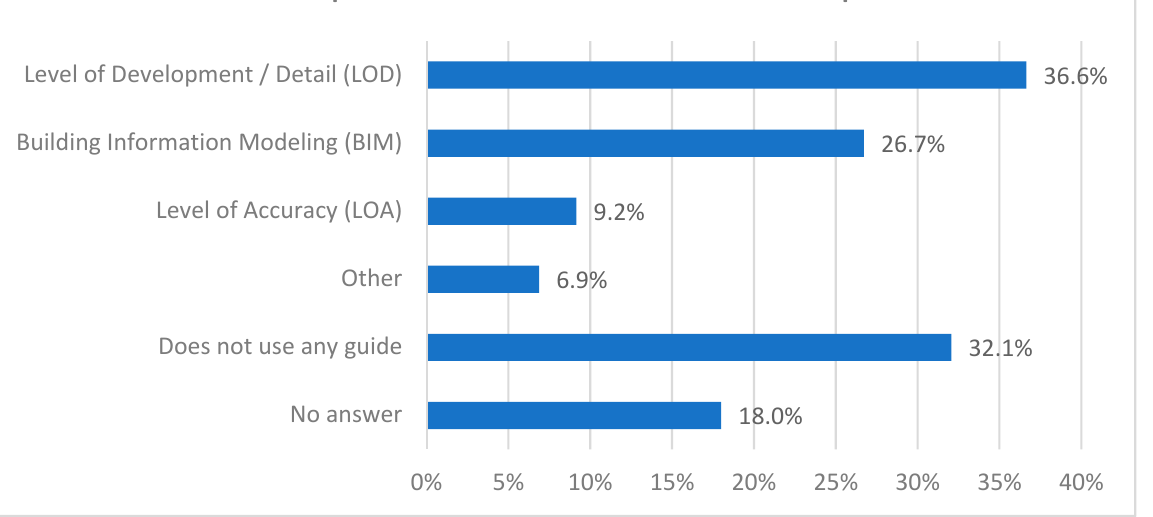
Figure 18. Guides of specification or standardization used in the scan-to-BIM process.